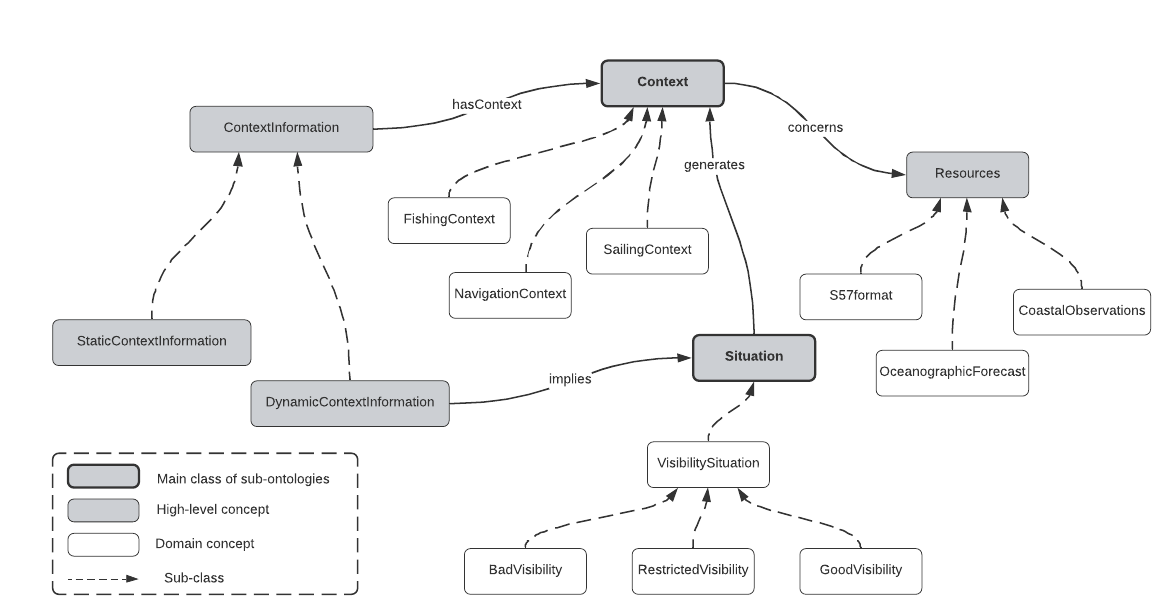
Figure 3. Partial taxonomy overview of concepts related to the sub-ontologies: context and situation.